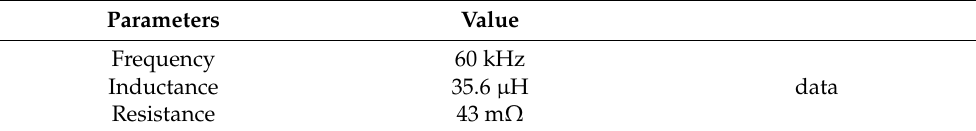
Table 4. EM simulation results of coils.